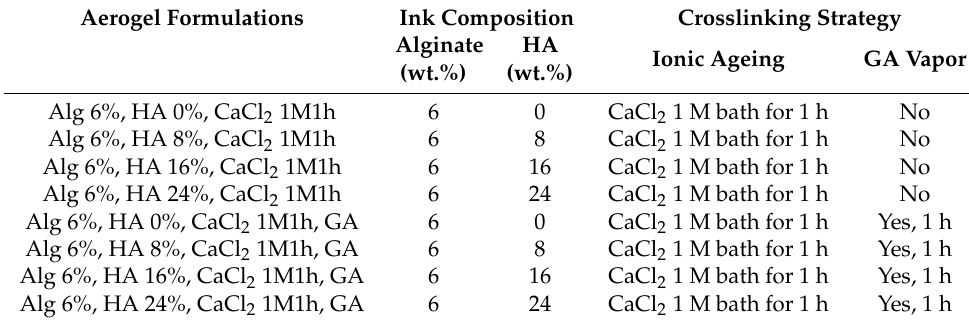
Table 1. Dual crosslinked alginate-HA aerogel formulations